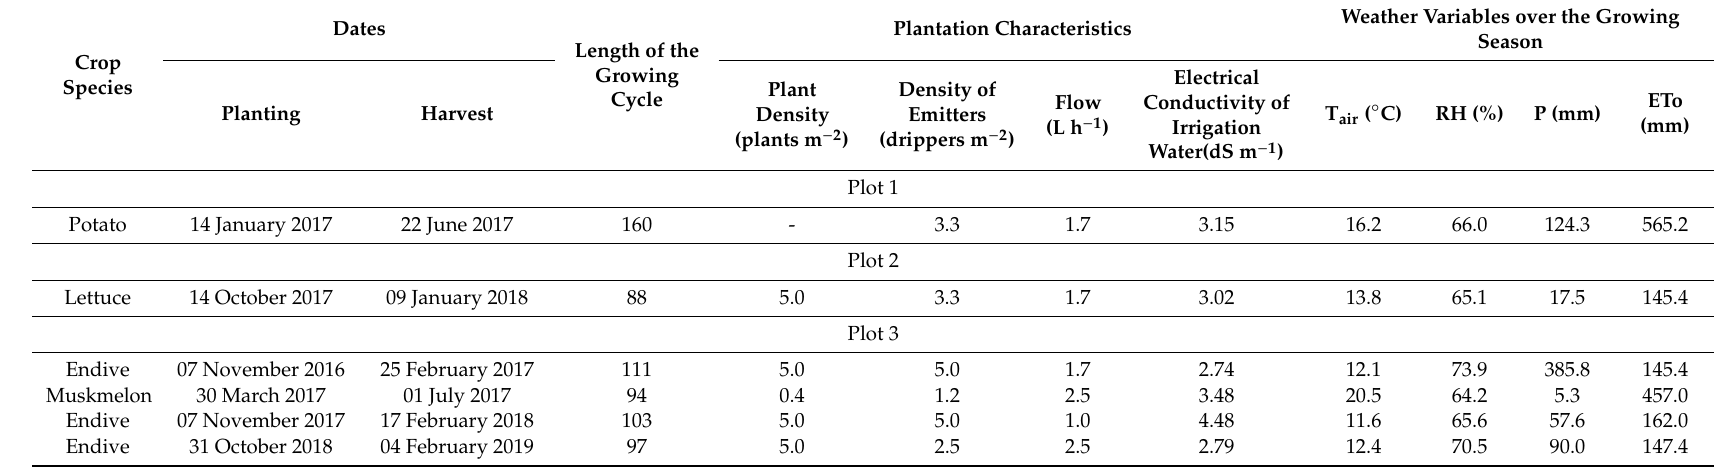
Table 1. Planting and harvest dates, length of the growing cycle and plantation characteristics for the di ff erent experiments and main weather data values for each growing season (mean air temperature, T air ; mean relative humidity, RH; total precipitation, P; and total reference evapotranspiration, ET o